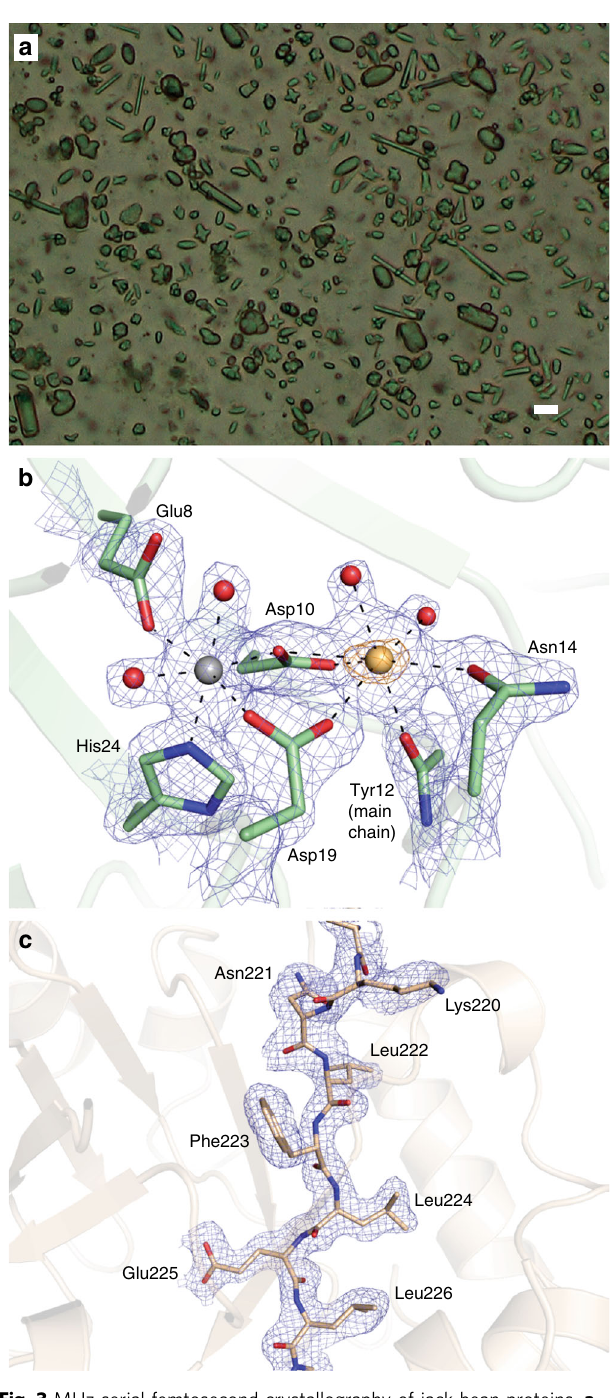
Fig. 3 MHz serial femtosecond crystallography of jack bean proteins. a Microscope image of the microcrystalline mixture of jack bean proteins that was injected into the X-ray beam, clearly showing different types of crystal forms. The scale bar is 10 µ m. b Map quality for the concanavalin A structure. The metal binding site is shown, with the simulated annealing composite omit map contoured at 1.0 σ shown as a blue mesh and the anomalous difference density map (5.0 σ ) shown as an orange mesh. Selected residues are shown as sticks, the calcium and magnesium ions as yellow and grey spheres, respectively. Water molecules are shown as red spheres. c Map quality for the concanavalin B structure. Part of one of the β -strands of the TIM-barrel is shown as sticks, with the simulated annealing composite omit map (1.0 σ ) shown as a blue